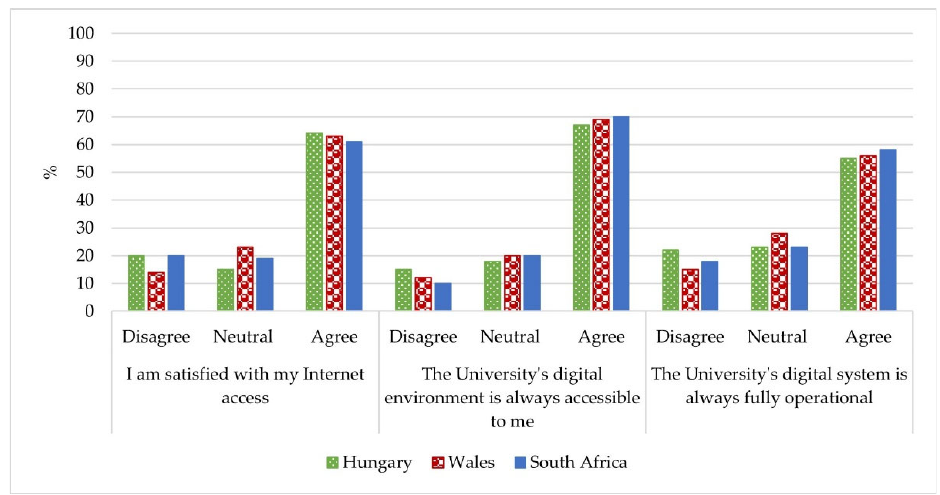
Figure 16. Digital access to the learning environment (%).